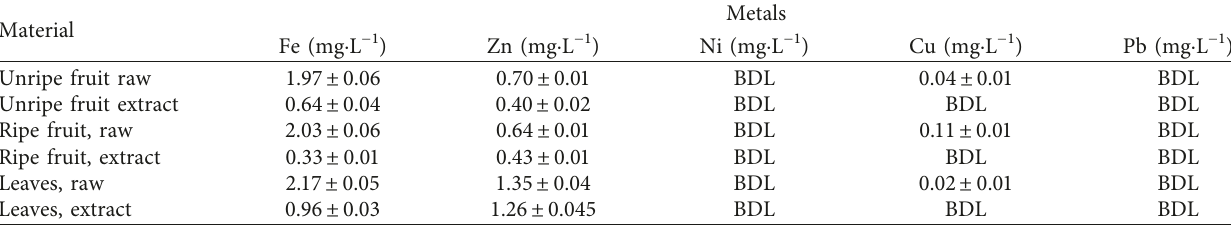
Table 2: Heavy metal content of raw plant materials and extracts.